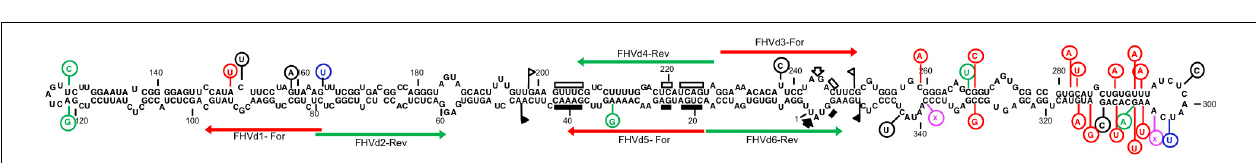
FIGURE 2 | Amplification assays using RNA preparations from FHVd-LR-positive and -negative samples, and primer pairs FHVd-5F/6R (left) or FHVd-3F/4R (right). Lane 1, amplification was performed in the absence of reverse transcription ( − RT) using an FHVd-LR-positive sample. Lanes 2 and 3, amplifications were performed after reverse transcription ( + RT) using RNA preparations from FHVd-LR-negative or -positive samples, respectively. Lane 4 is a non-template control. The same FHVd-LR-positive sample was tested in lanes 1 and 3.